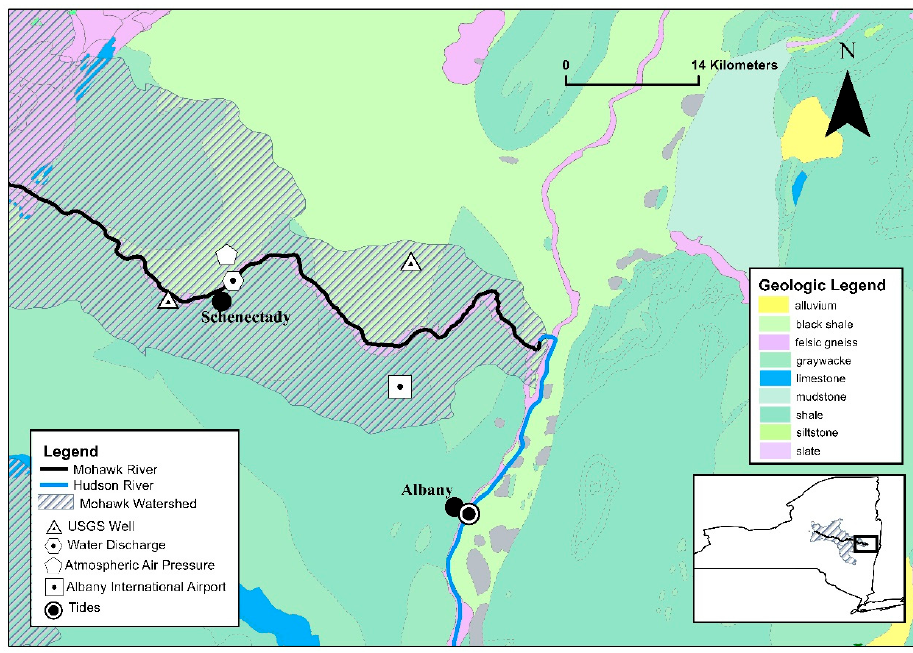
Figure 1. A map of Upstate New York made in ArcMap showing the Mohawk watershed, the Mohawk River and the location of Schenectady. All points indicate the location of the climatic and hydrogeological data that are derived from the monitoring stations. Geological data were derived from New York State [35].